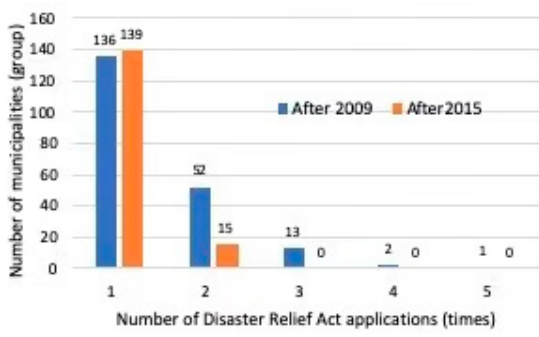
Figure 4. Presence or absence of disaster experience.